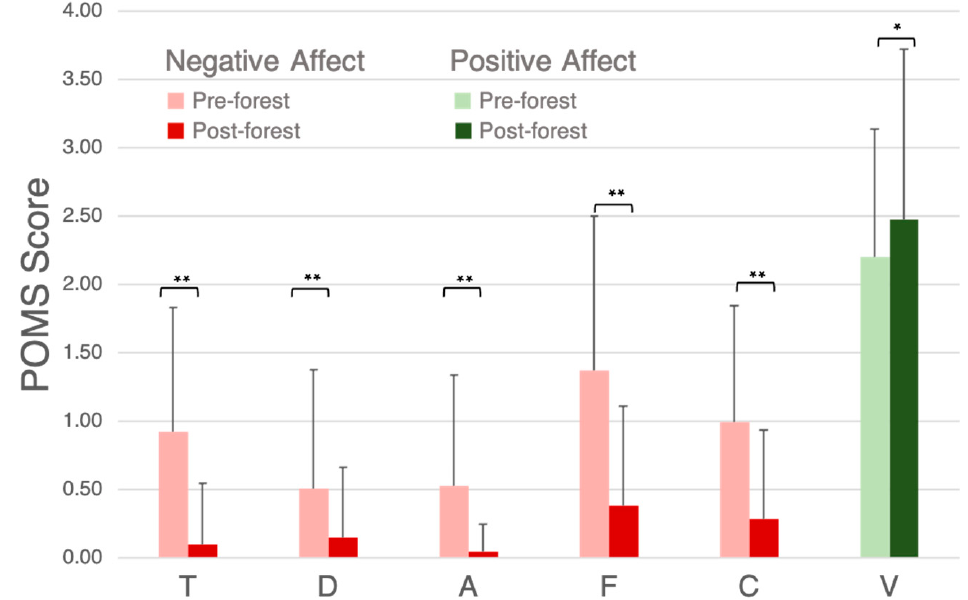
Figure 3. POMS results pre-forest and post-forest. T: tension and anxiety, D: depression and dejection, A: anger and hostility, F: fatigue, C: confusion, V: vigor. Significant differences are marked with * p < 0.05 and ** p < 0.01.